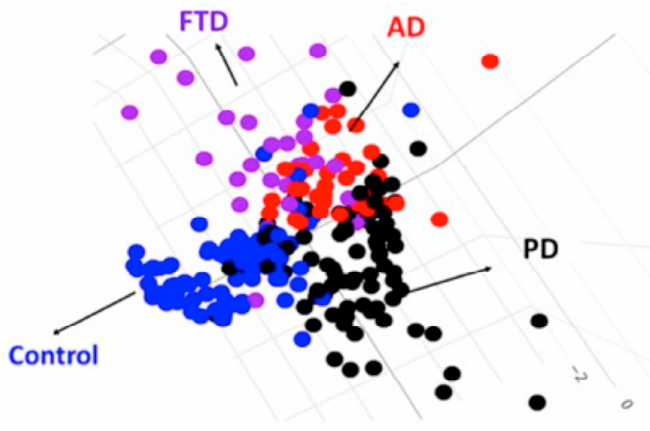
Figure 3. The 3D scatter plot demonstrates that LDA separated sample points of different dementia groups. AD: AD spectrm, PD: PD spectrum.